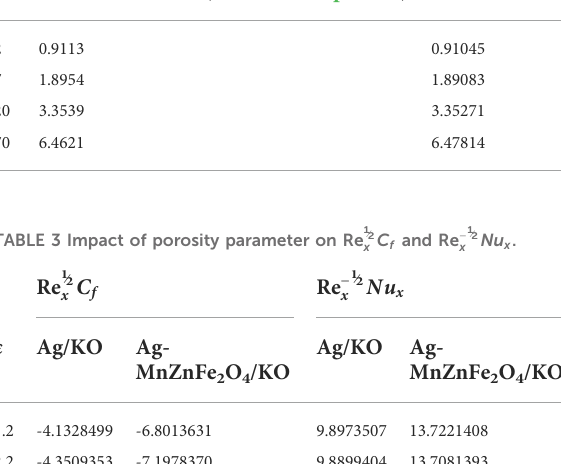
TABLE 2 Change in heat-transfer rate for different Prandtl numbers when ϕ 1 (cid:2) ϕ 2 (cid:2) 0. Pr Literature results (Khan and Pop, 2010) Present results